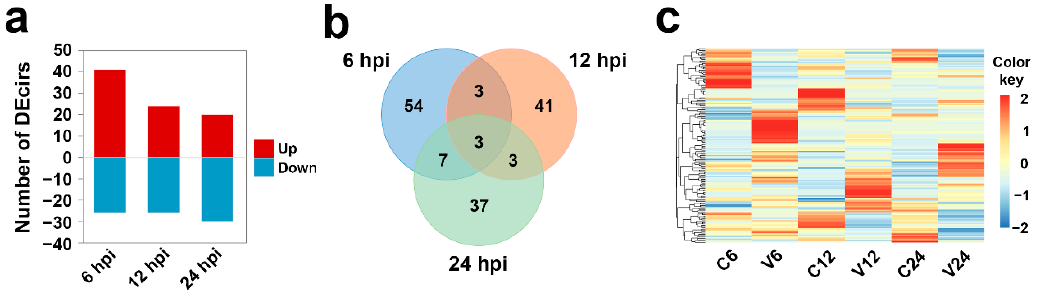
Figure 3. Differentially expressed circRNAs (DEcirs) induced by V. anguillarum infection at different time points. ( a ) Number of DEcirs at 6, 12, and 24 h post-infection (hpi). “Up” and “Down” indicate up- and downregulated expression, respectively. ( b ) Venn diagram showing overlapping DEcirs at different time points. ( c ) Heat-map showing the expression patterns of DEcirs in different groups at different time points. For convenience, “C6”, “C12”, and “C24” indicate the control groups at 6, 12, and 24 h post-infection (hpi), respectively; “V6”, “V12”, and “V24” indicate the V. anguillarum -infected groups at 6, 12, and 24 hpi, respectively.